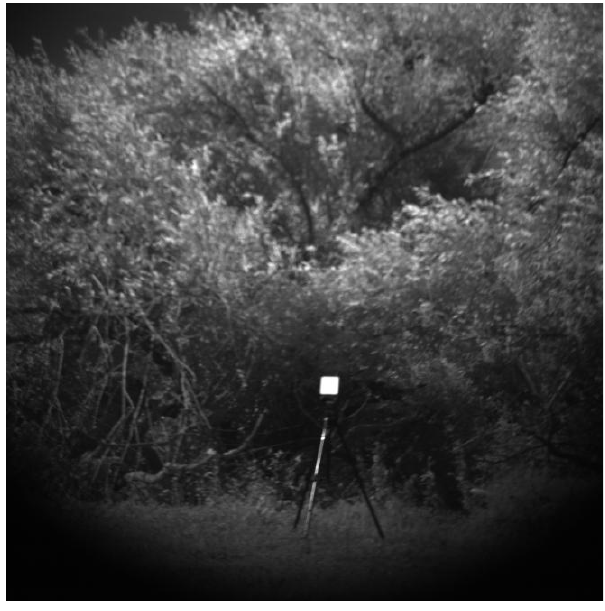
Figure 6. Image at wavelength 720 nm of the hyperspectral cube of Salix 4 in Location